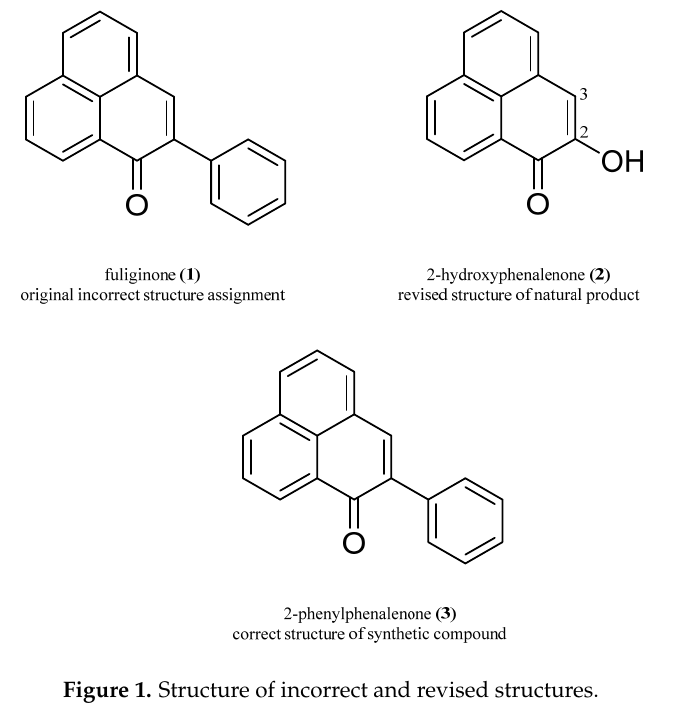
Figure 1. Structure of incorrect and revised structures.